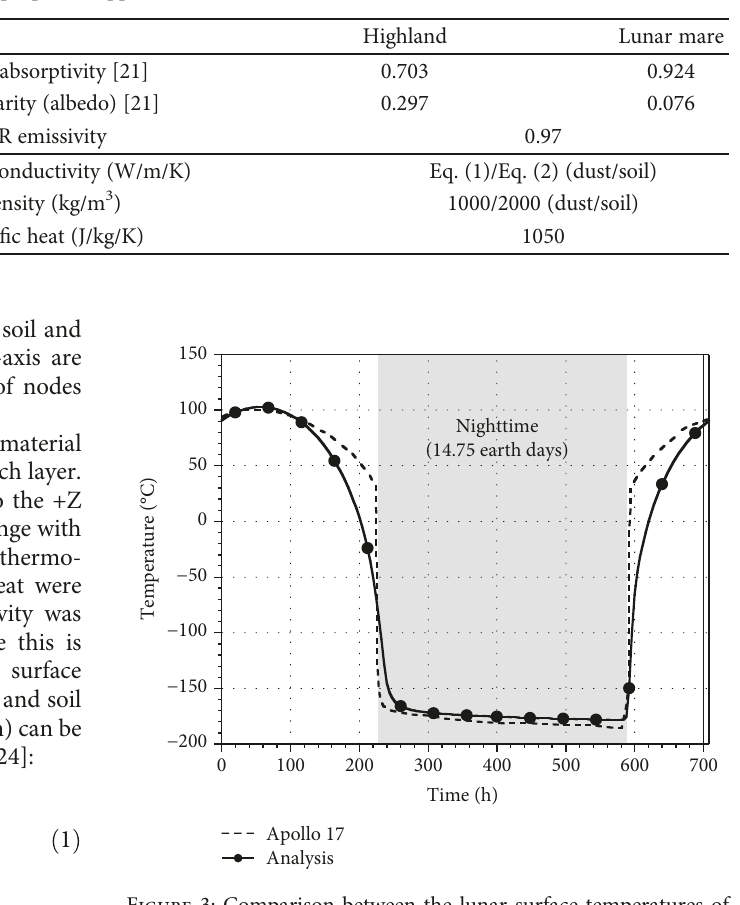
Figure 2: TMM of the lunar regolith. Table 2: Material properties applied to thermal model [22].